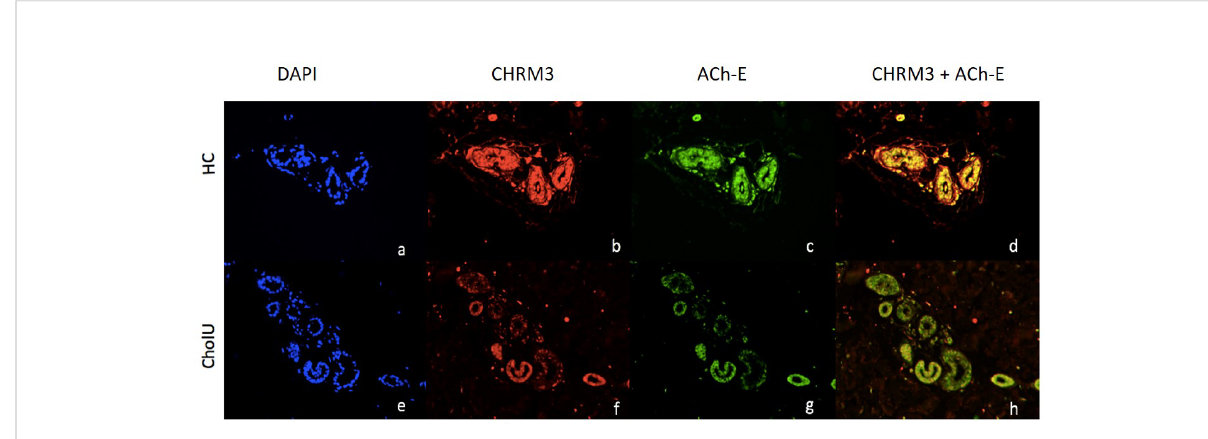
FIGURE 6 Representative immunohistochemical examination patterns of the expression of CHRM3 and ACh-E of non-lesional skin before provocation in HC (A – D) and CholU patients (E – H) . (A, D) DAPI staining of nuclei of sweat glands; (B, E) CHRM3 staining (red); (C, F) ACh-E staining (FITC) d/g CHRM3 and ACh-E